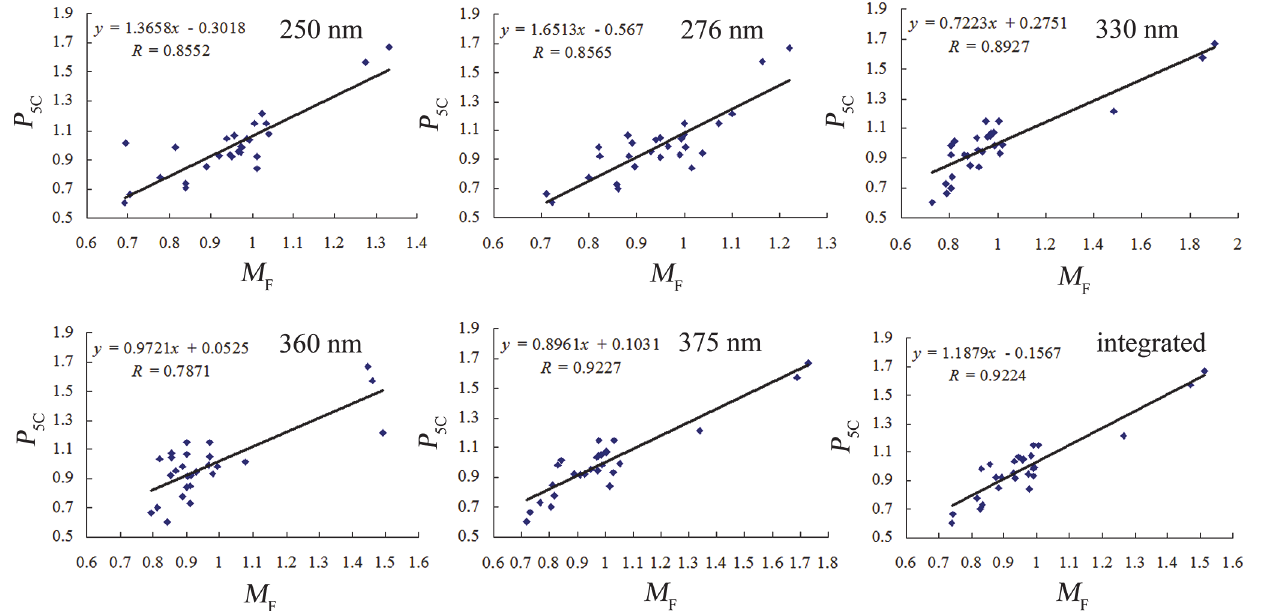
Fig 5. Correlation between P 5C and M F for CBAT samples at 6 wavelengths. (A) 250 nm (B) 276 nm (C) 330 nm (D) 360 nm (E) 375 nm (F) integrated